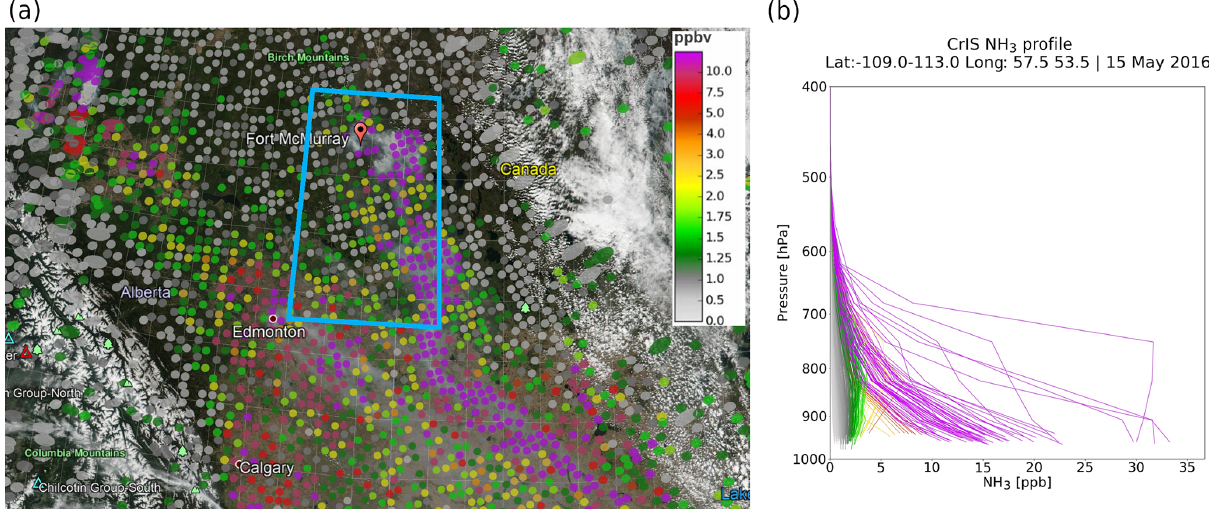
Figure 2. Overlay of the CrIS-retrieved surface NH 3 pixels on the VIIRS true-colour visible imagery for 15 May 2016 showing the plume from the Fort McMurray fires (a) . Retrieved NH 3 profiles colour coded using the surface level values in the blue box on the map (b) . (Underlying VIIRS images obtained from NASA Worldview – https://worldview.earthdata.nasa.gov/, last access: 19 February